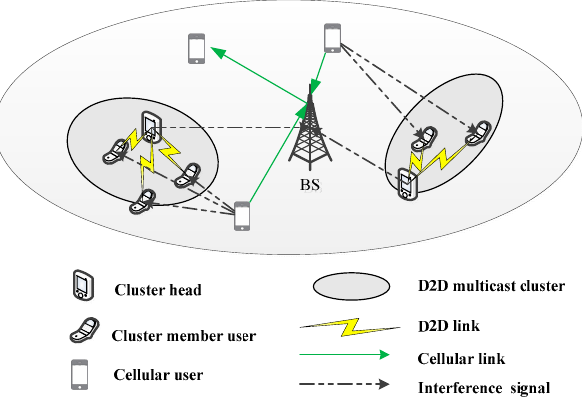
Figure 1. The considered device-to-device (D2D) multicast transmission network model. BS: base station.